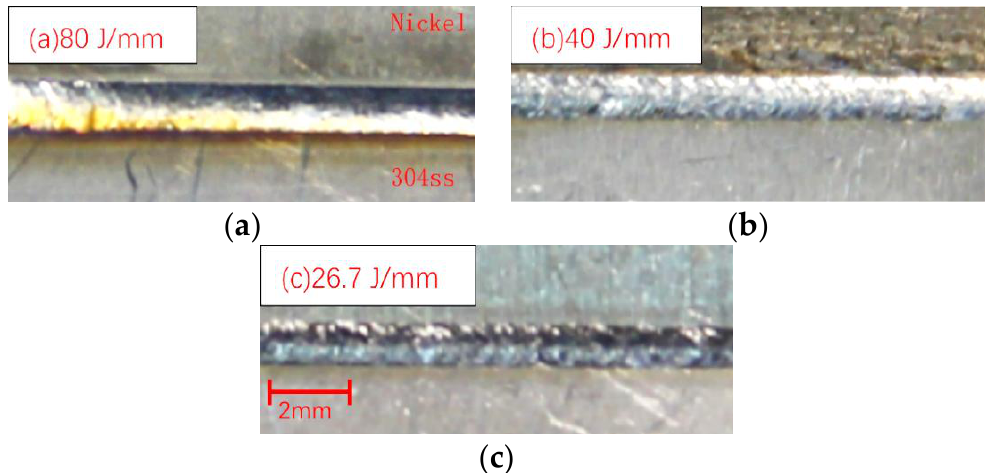
Figure 5. Weld beads by LBW at different heat input. ( a ) 80 J/mm. ( b ) 40 J/mm. ( c ) 26.7 J/mm.